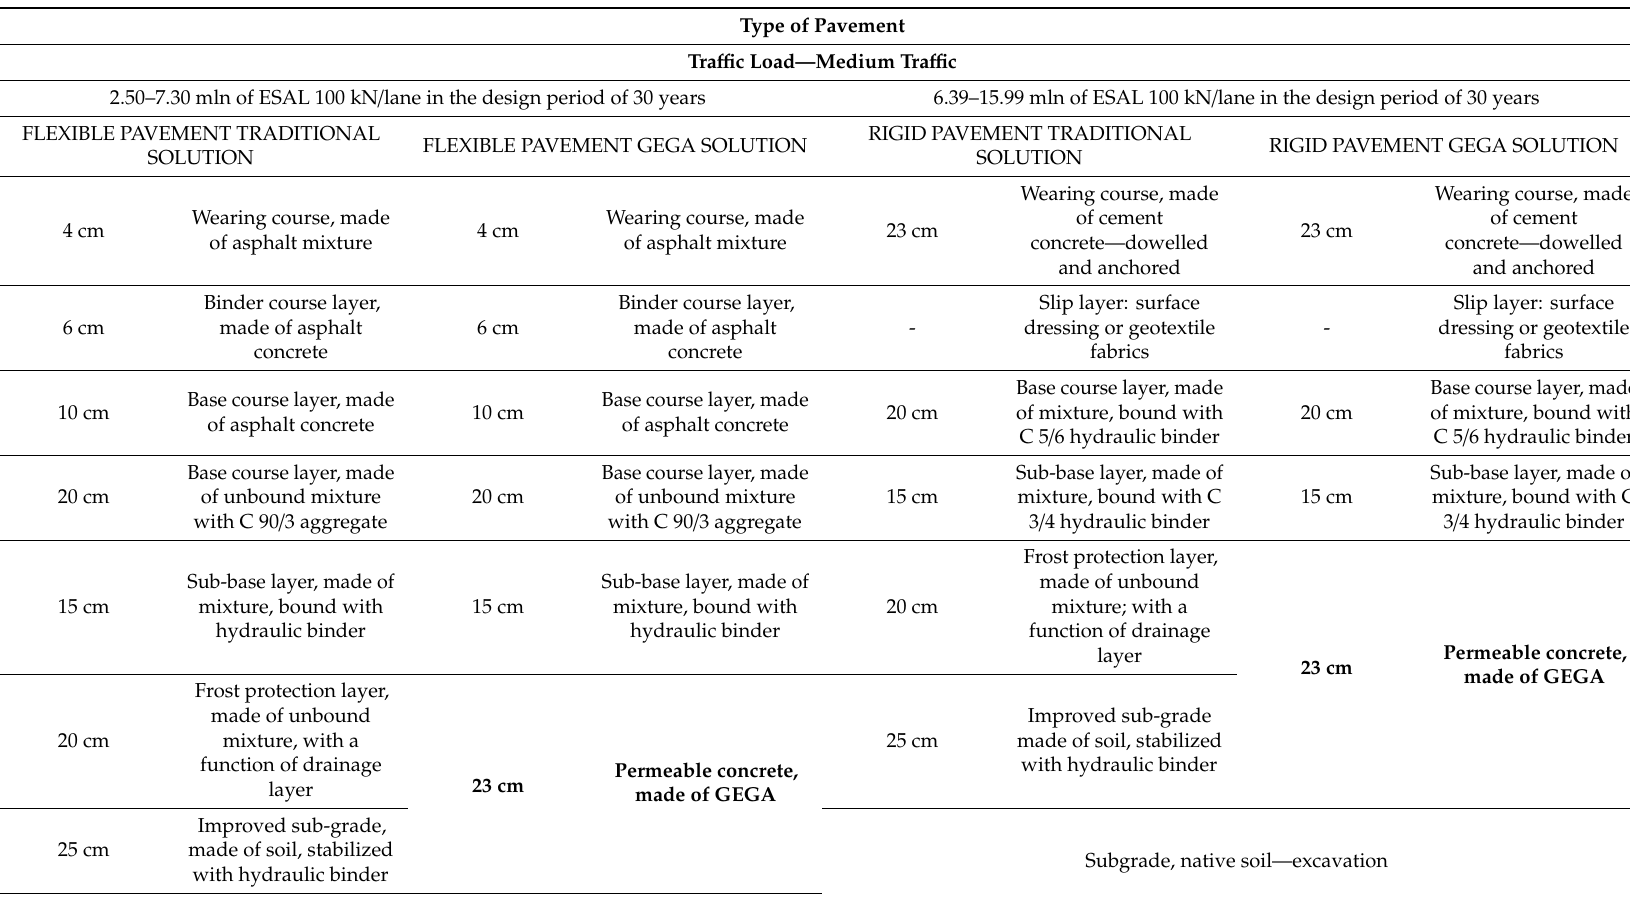
Table 5. Resulted structural layers of flexible and rigid pavements—traditional and permeable concrete, made of GEGA, solutions for medium tra ffi c. Type of